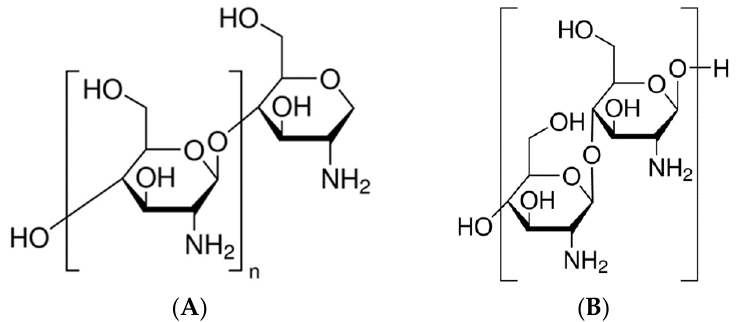
Figure 1. The chemical structure of ( A ) chitosan and ( B ) chitosan oligosaccharide